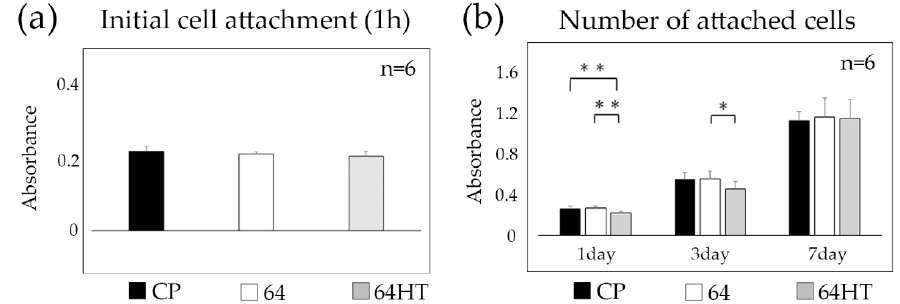
Figure 4. ( a ) Initial attachment of GE1 cells was analyzed 1 h following seeding. ( b ) The number of GE1 cells was analyzed after 1, 3, and 7 days of incubation. Data are shown as the mean ± SD.